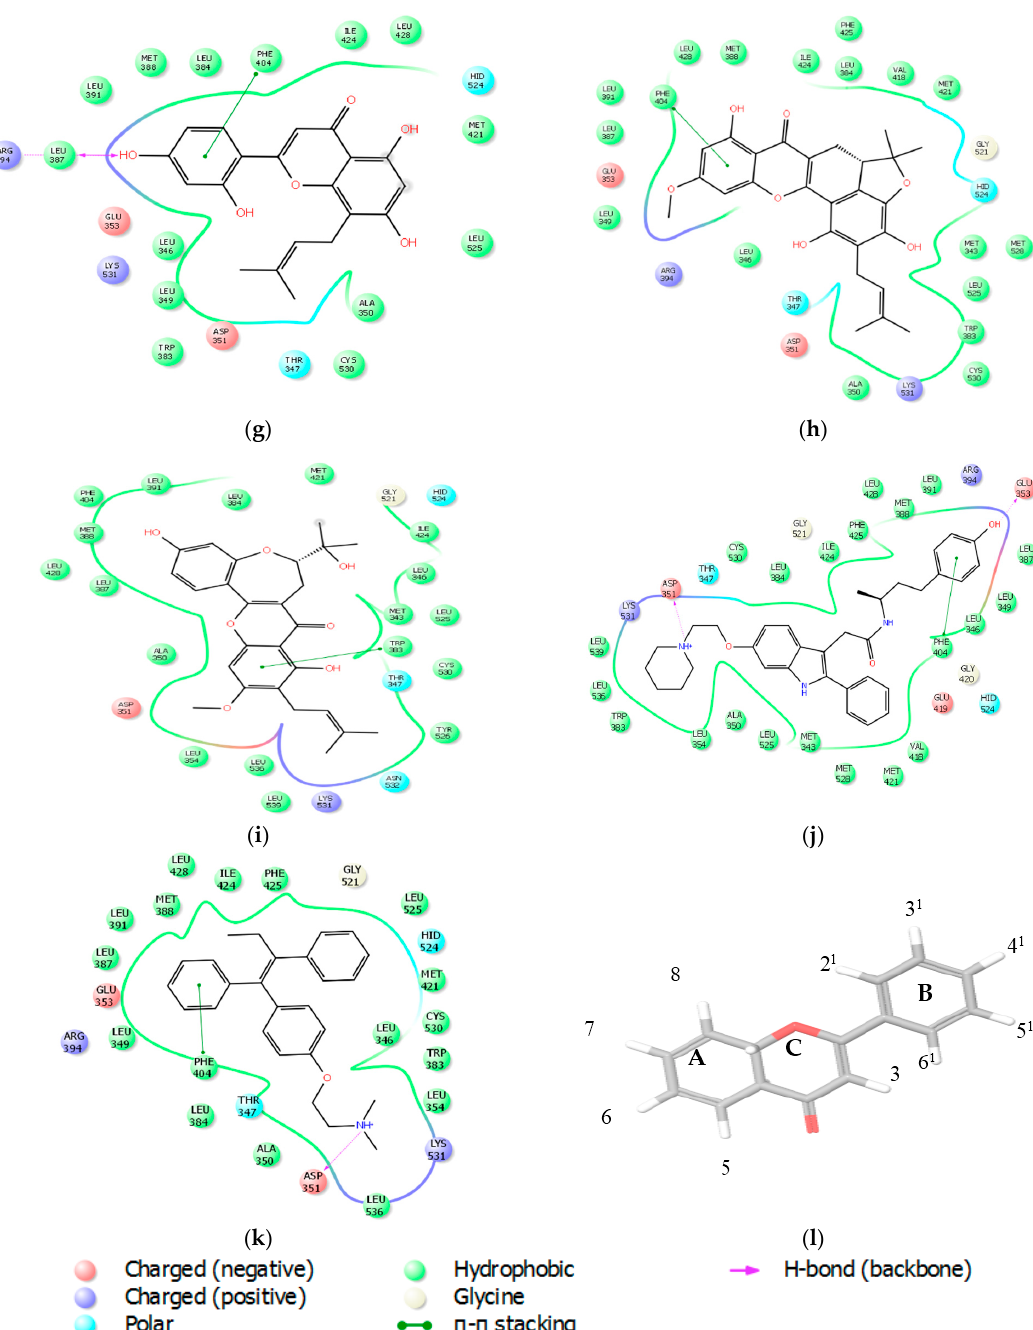
Figure 3. Molecular interactions of studied ligands with crucial amino acids at the ligand-binding domain of hER α : ( a ) Artonin E; ( b ) Artobiloxanthone; ( c ) Artelastin; ( d ) Artonin U; ( e ) Cycloartocarpesin; ( f ) Artonin L; ( g ) Artonin Y; ( h ) Artonin T; ( i ) Artonin S; ( j ) Native ligand, 11F; ( k ) Tamoxifen; and ( l ) A flavone skeleton.